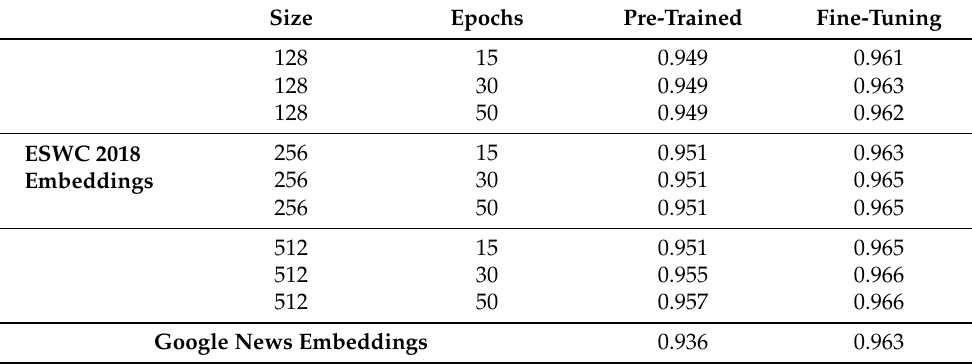
Table 1. Results obtained before and after embedding polarization.